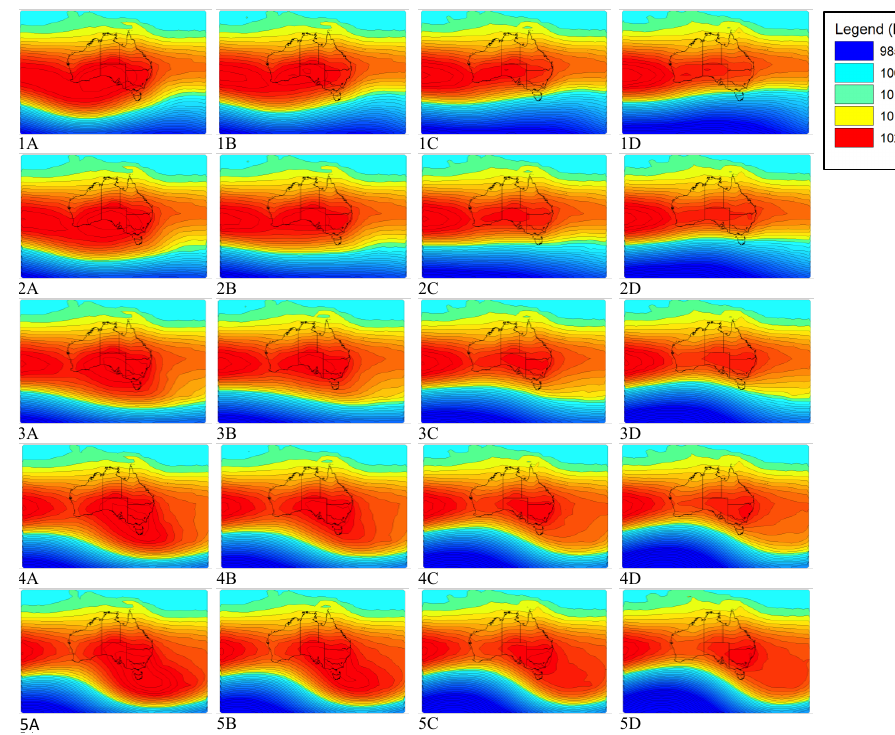
Figure 9. The 20 winter synoptic types identified using SOM based on data from 1948–2009.